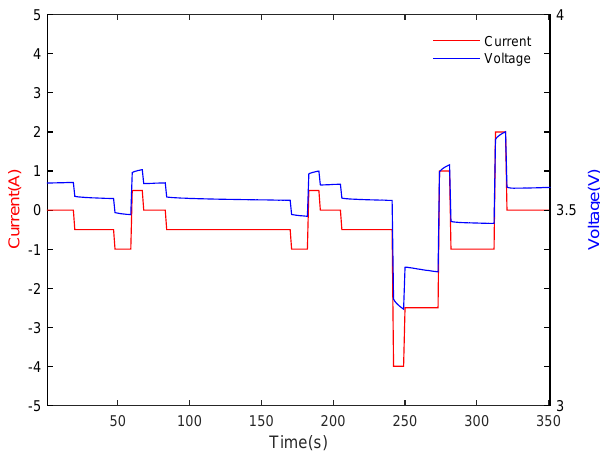
Figure 3. Current and voltage data of a DST cycle.